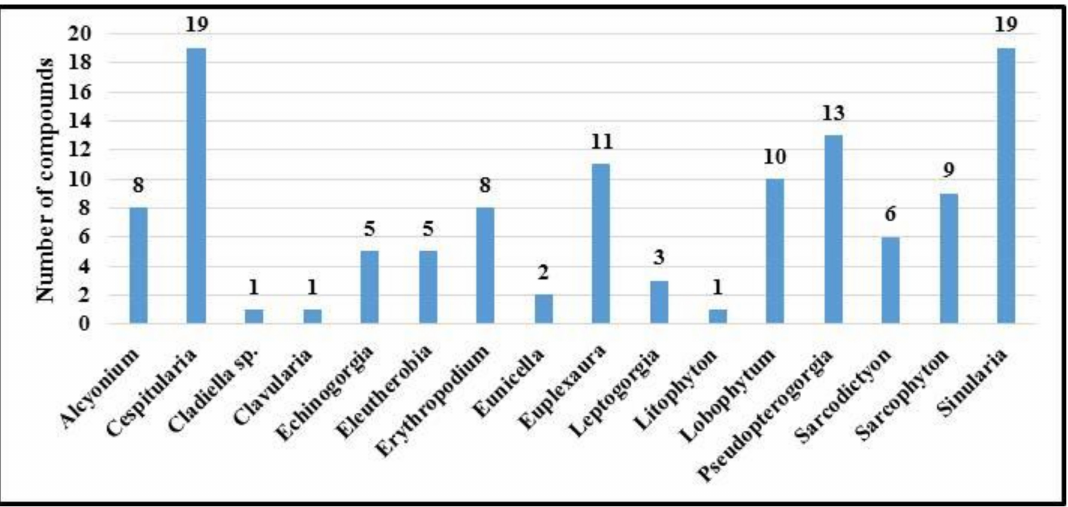
Figure 13. Distribution of nitrogen containing metabolites isolated from soft corals by genus.